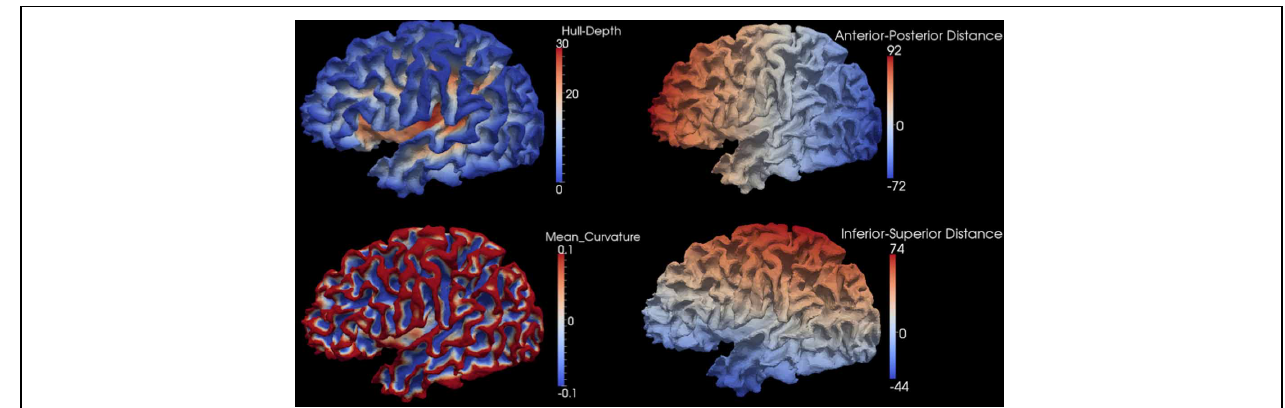
FIGURE 1 | Four geometry features calculated for the surface of one cortical hemisphere for a single subject. Surfaces are colored by scalar values associated with vertices. Features names and scalar ranges are shown